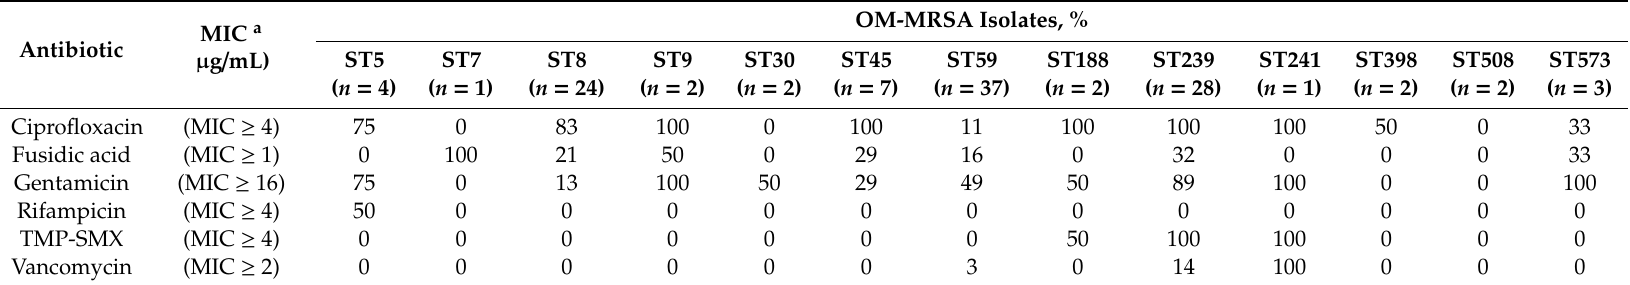
Table 5. The relationship between the antibiotic resistance and MLST genotypes for OM-MRSA isolates ( n =